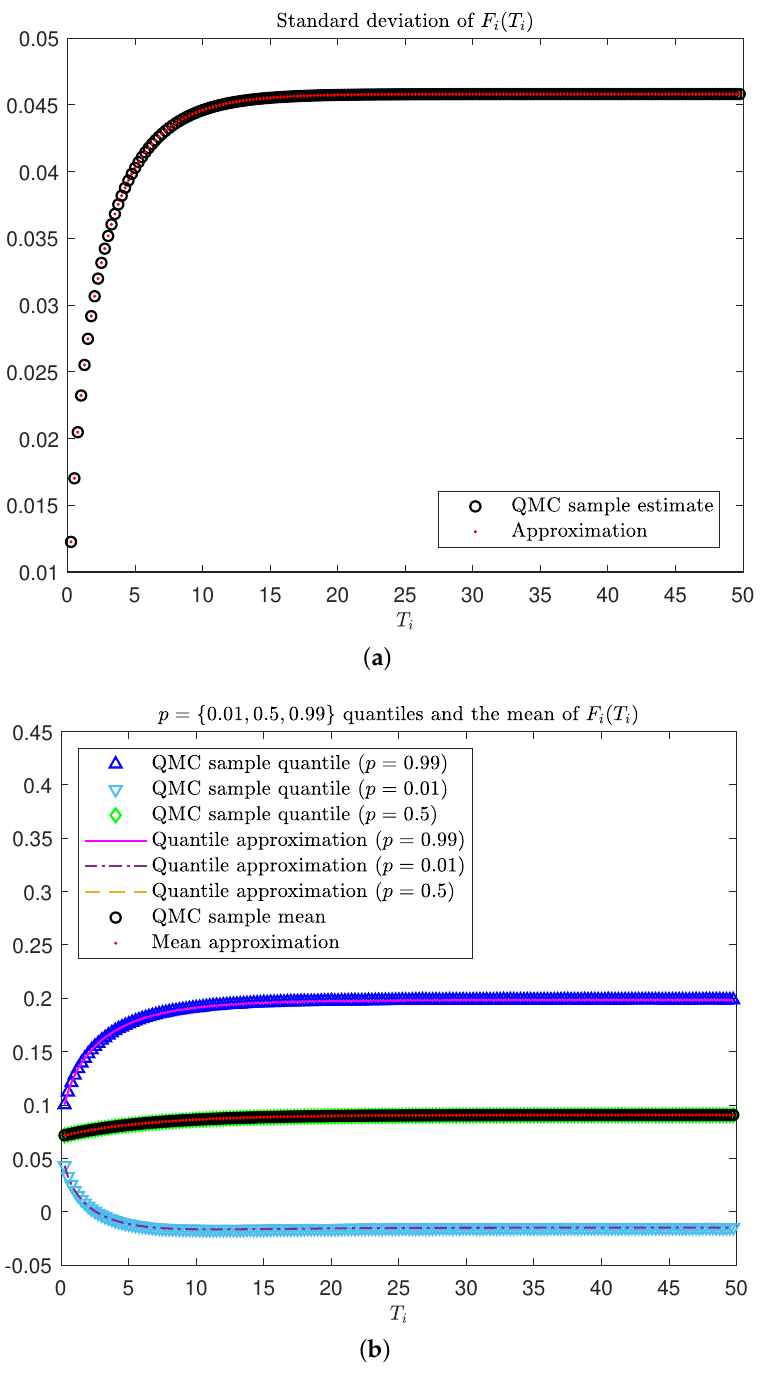
Figure 1. Diagnostic tool for analysing the distribution of long-dated forward LIBORs in the discretized Vasiˇcek model. ( a ) Comparing the realised forward LIBOR standard deviation ap- proximation to a benchmark QMC sample estimate. ( b ) Comparing the realised forward LIBOR p = { 0.01,0.5,0.99 } quantile and mean approximations to their benchmark QMC sample